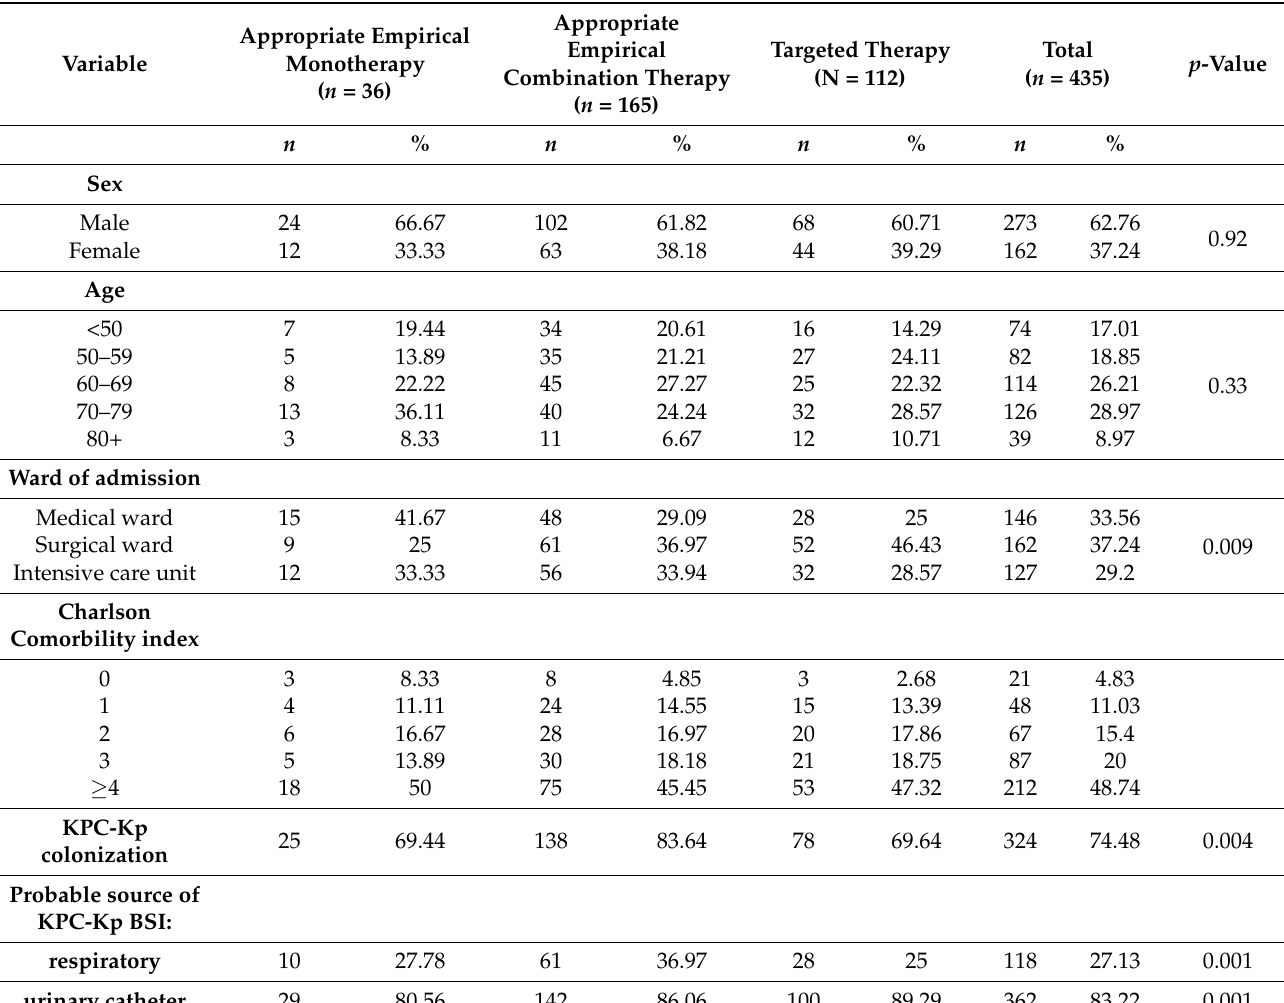
Table 1. Baseline characteristics of the study population treated with appropriate therapy ( n =